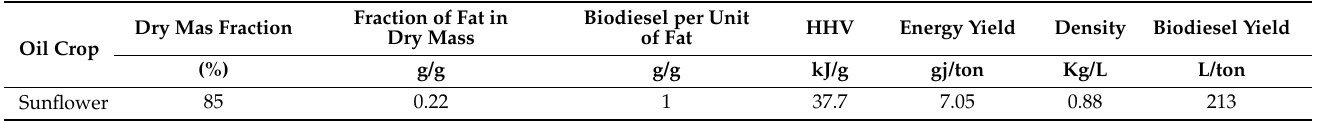
Table 3. Biodiesel characteristics.